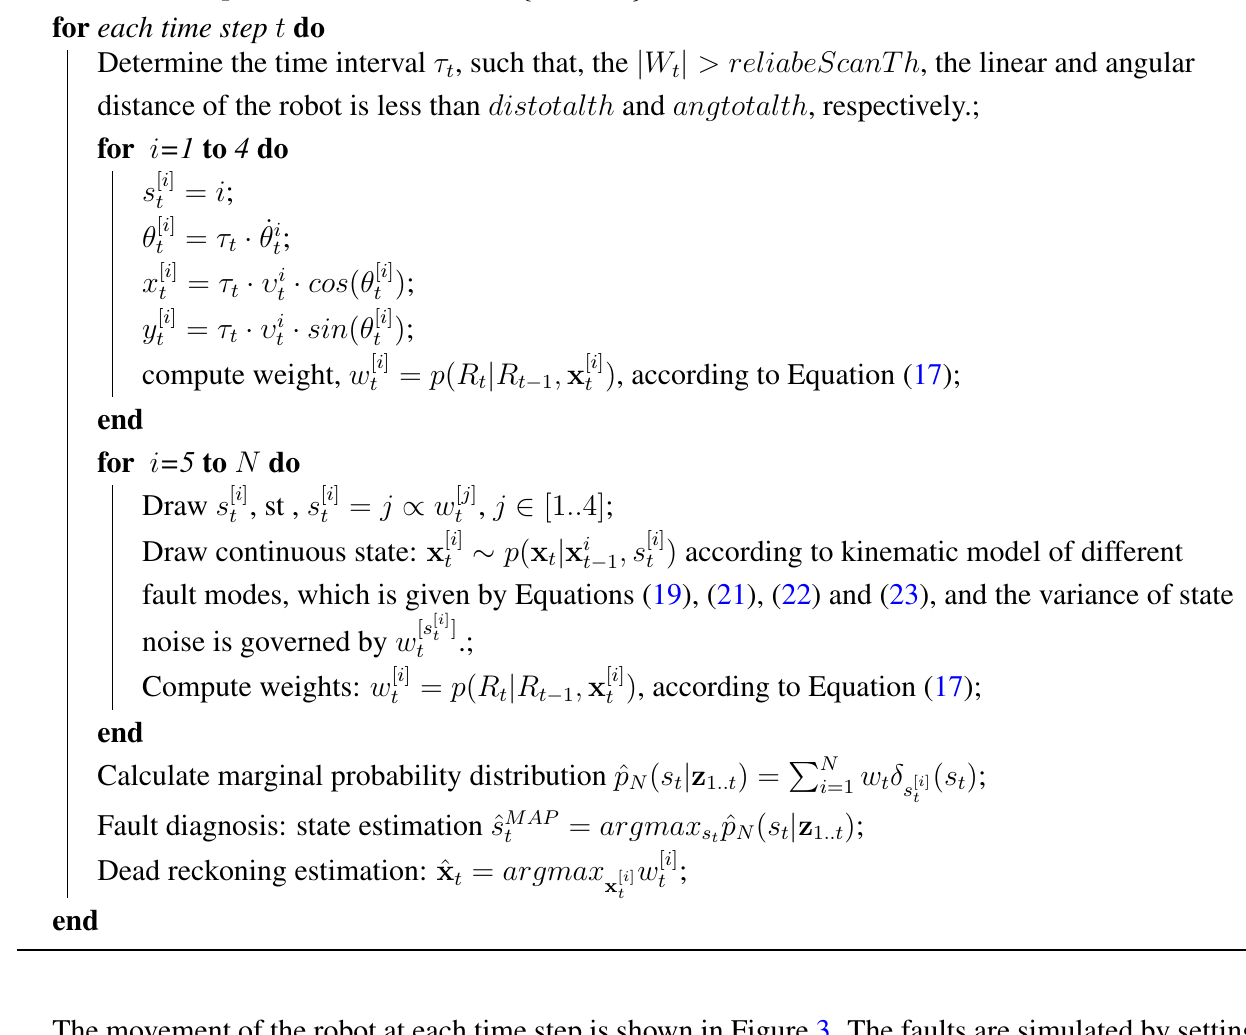
Algorithm 2: Particle filter for simultaneous fault diagnosis and robust dead reckoning. Initialize: Set particle number N , S = { 1 , 2 , 3 , 4 }